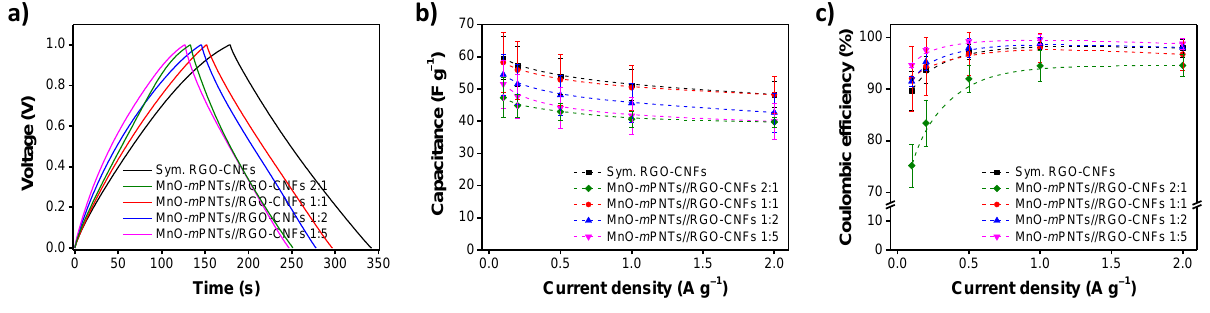
Figure 14. Effect of electrode weight: ( a ) Representative charge/discharge curves measured at 0.1 A·g −1 ; ( b ) Specific capacitances; and ( c ) Coulombic efficiencies measured at different current densities. With permission from [100]; Copyright 2014, The Royal Society of Chemistry.